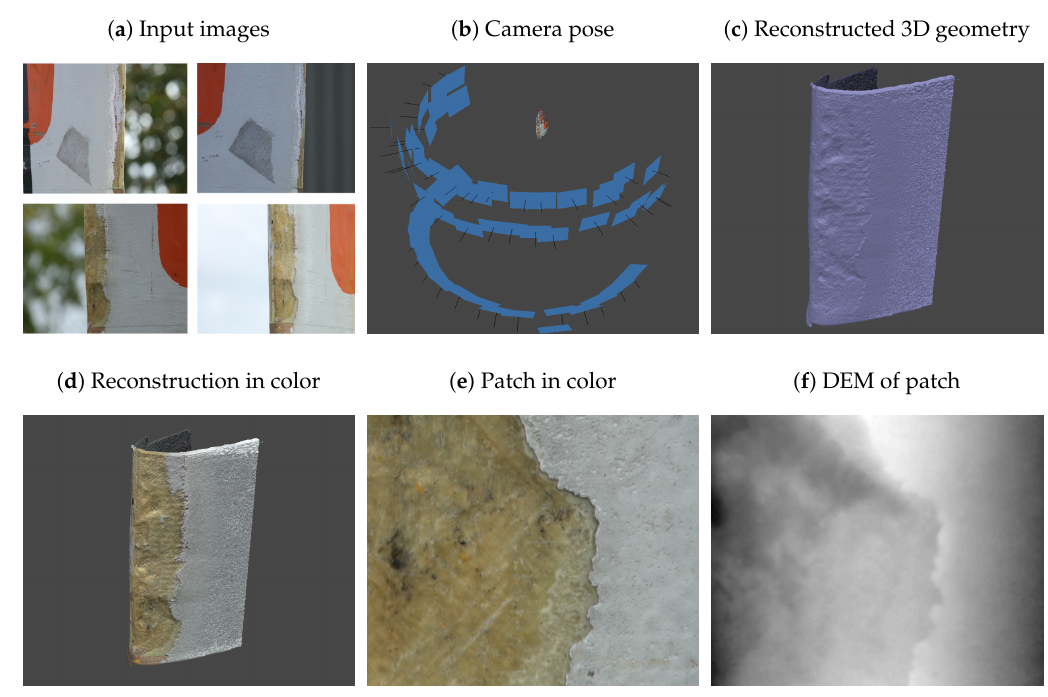
Figure 3. Pipeline for 3D reconstruction using SfM. ( a ) Initially, images were acquired at every 10 degrees of a half circle around the wind turbine blade at three different heights and tilt angles. ( b ) The camera pose of the images and points on the object surface were then calculated. The reconstructed surface geometry without ( c ) and with color ( d ). Extracted patch from the reconstruction shown as ( e ) (color) texture and ( f ) resulting